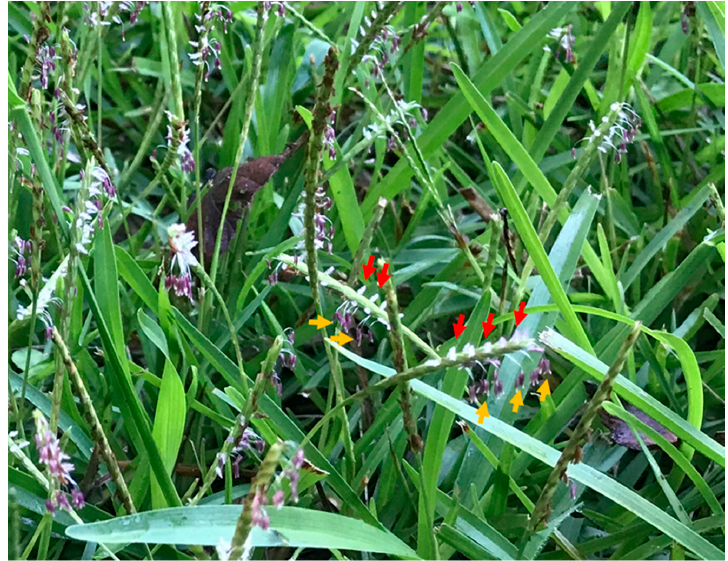
Figure 1. Spike-like inflorescences of centipede grass emerged 12 d after mowing in a residential lawn in Pike County, GA, USA, during September 2020. The androecium (stamens) (purple anthers and white filament) containing pollen (indicated by orange arrows) and gynoecium (carpel) (white stigma, and style), which receive pollen (indicated by red arrows) are shown in the figure. Photo credit: Shimat